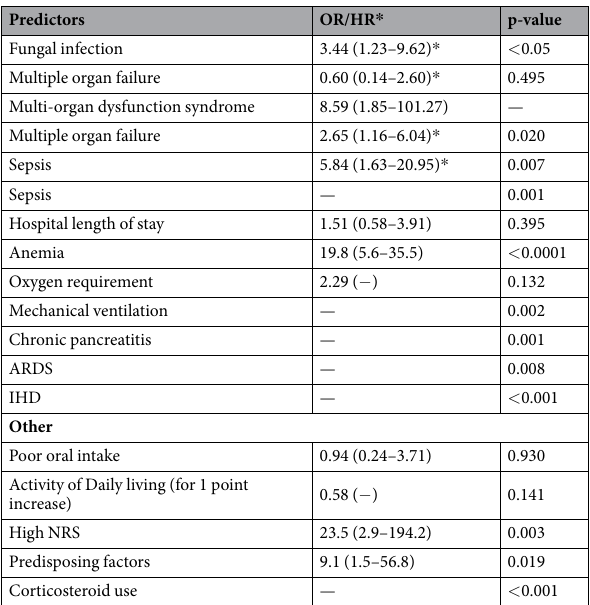
Table 4. Unpooled predictors for in-hospital mortality among TB